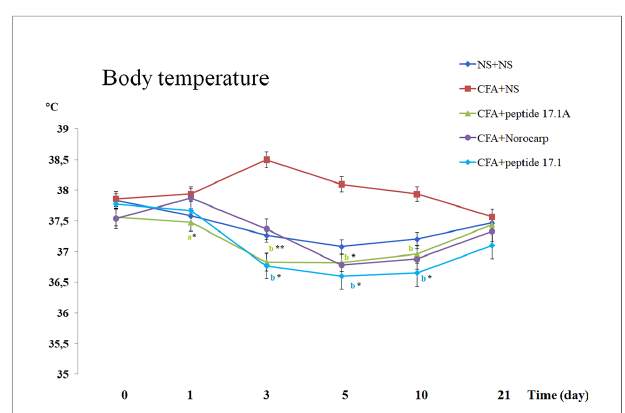
FIGURE 5 | Body temperature changes in CFA-induced arthritis in mice of control, CFA-control (treatment of NS), 17.1A, Norocarp, 17.1 (CFA — complete Freund ’ s adjuvant; NS — normal saline). All data are presented as mean ± SEM for at least three independent replicates. a p < 0.05, b p < 0.01 vs CFA+NS; *p < 0.05, **p < 0.01 vs baseline on 0 day. (n = 10 in each